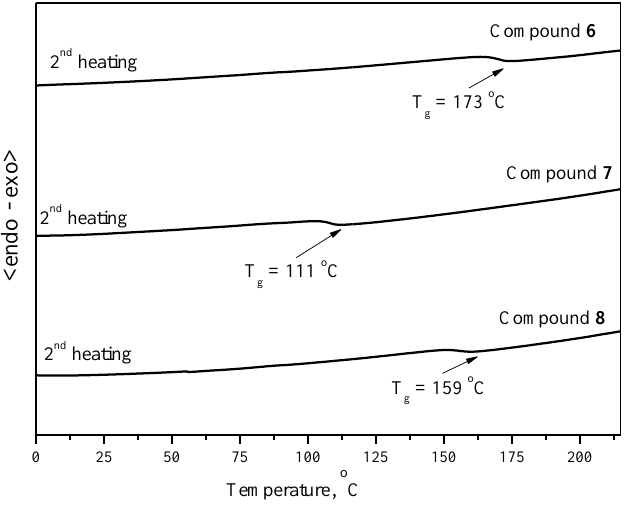
Figure 2. DSC curves of second heating of the materials 6 – 8 . Heating rate: 10 °C·min −1 .